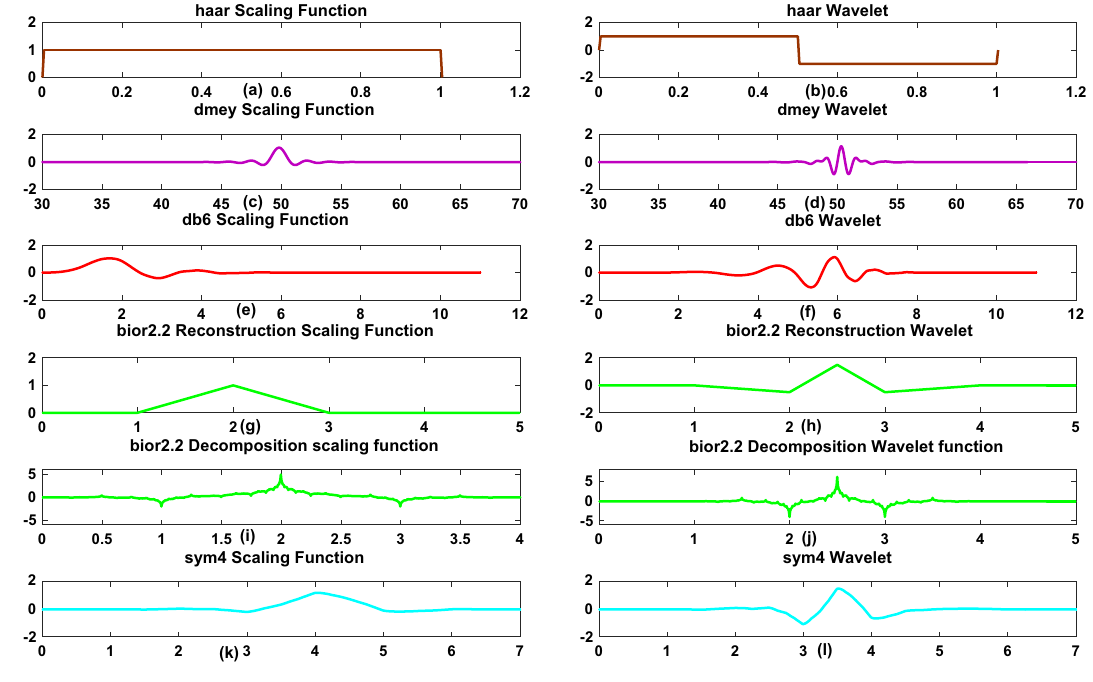
Figure 5. Scaling and wavelet functions of various wavelet